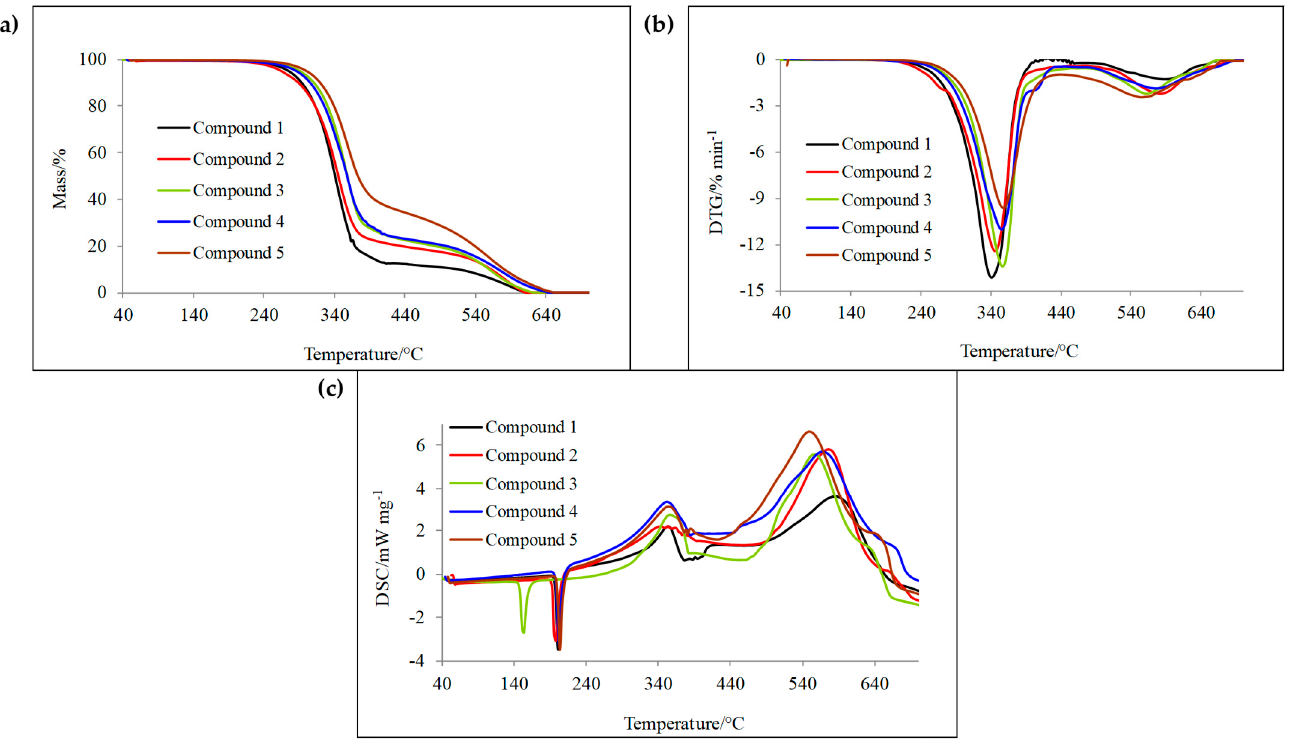
Figure 7. The TG ( a ), DTG ( b ) , and DSC ( c ) curves of compounds 1 – 5 (a synthetic air atmosphere).